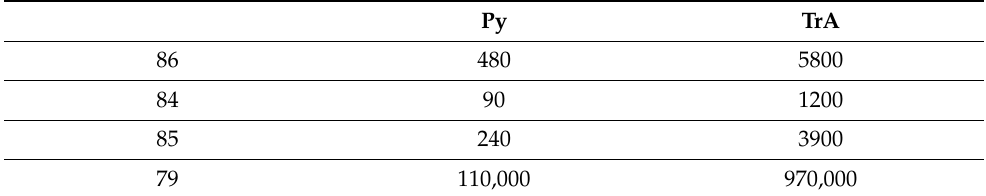
Table 6. Stability constants, K a [M − 1 ], of 1:1 complexes of porphyrinates ( 79 , 84 – 86 ) and